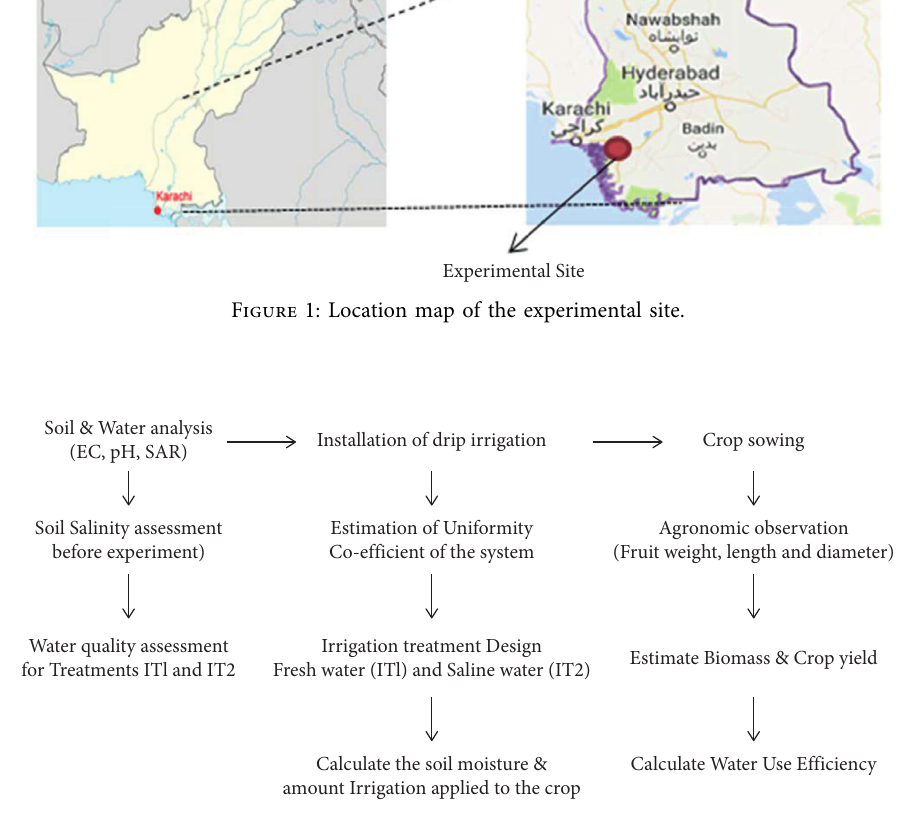
Figure 2: Flow chart of the